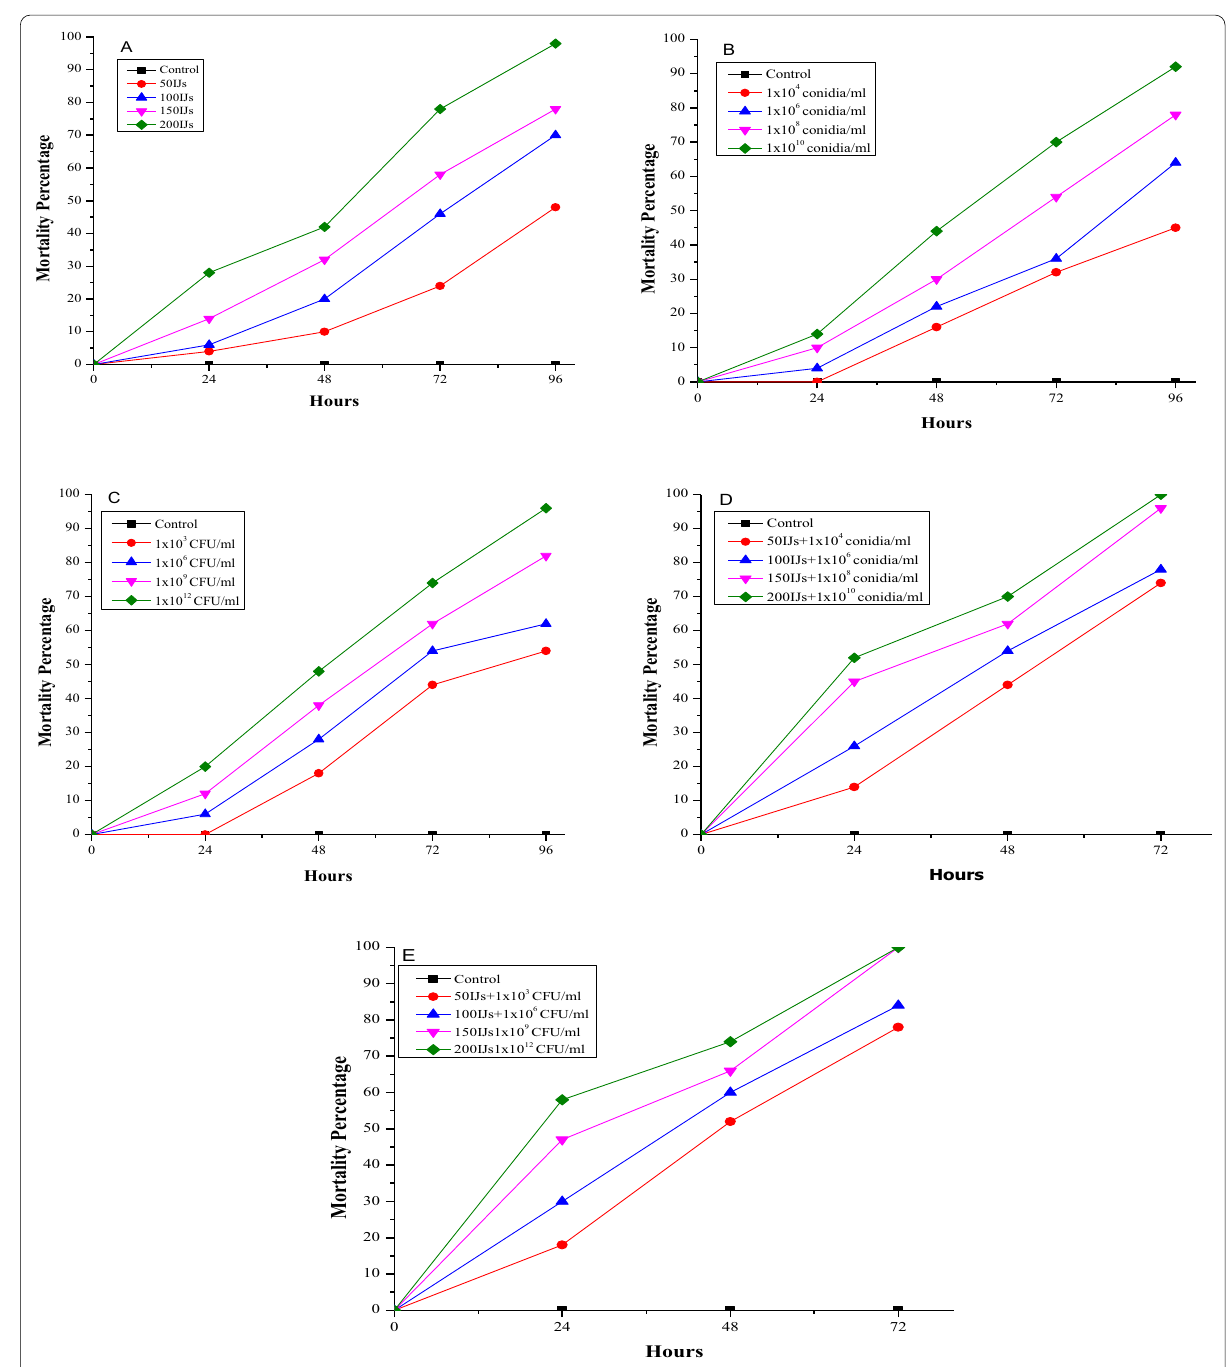
Fig. 1 Application of entomopathogens as a biocontrol agent against 3rd instar larvae of Spodoptera litura under laboratory conditions. Insect mortality percentage by using A Heterorhabditis bacteriophora , B Beauveria bassiana , C Bacillus thuringiensis , D H. bacteriophora bacteriophora B. +